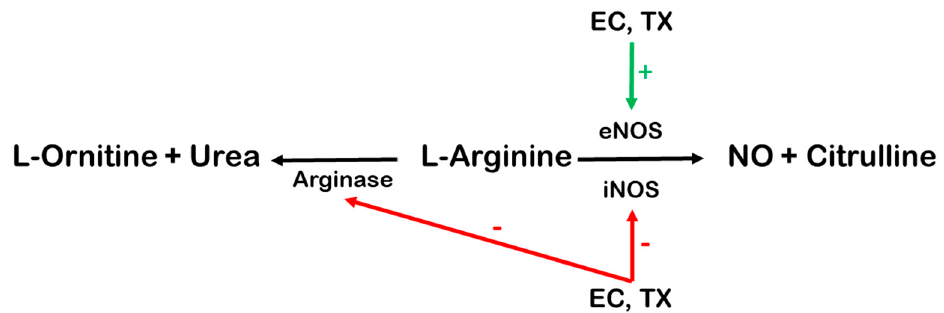
Figure 3. The EC- and TX-induced beneficial mechanisms involved in NO production. The green arrow indicates stimulation of the enzyme, which leads to the augmentation of NO production by eNOS. The red arrows indicate the EC- and TX-induced inhibition of the enzymes, leading to downregulation of iNOS in injured tissue and the inhibition of arginase. Abbreviations: EC, ( − )-epicatechin; eNOS, endothelial nitric oxide synthase; NO, nitric oxide; TX, (+)-taxifolin, ( − )-taxifolin or their racemic mixture.